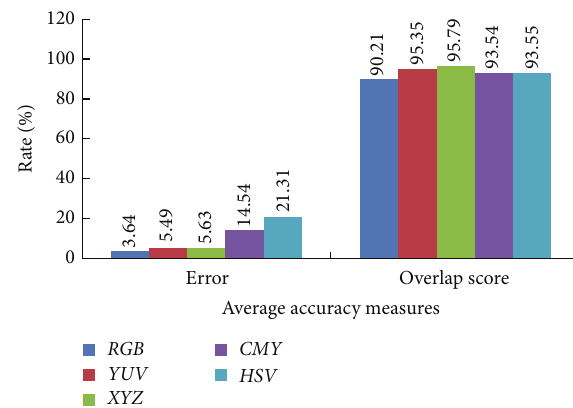
Figure 6: Comparison of average accuracy measures for applying automatic GrabCut segmentation on different color